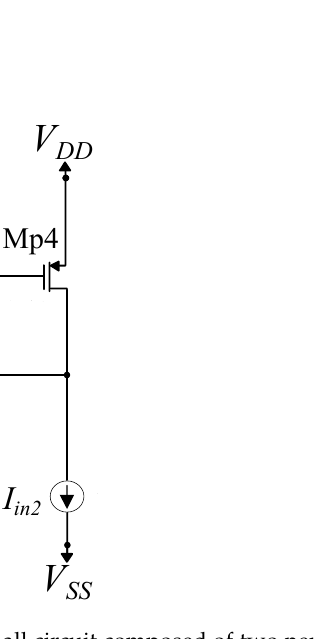
Figure 12. Simple PMOS winner-take-all circuit composed of two neuron cells. It is suitable for a 2-class classification problem.